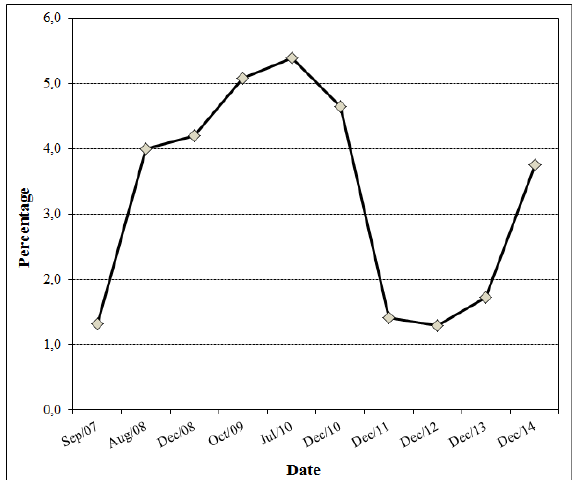
Figure 3. Time evolution of the percentage of non-integrated OHSMSs